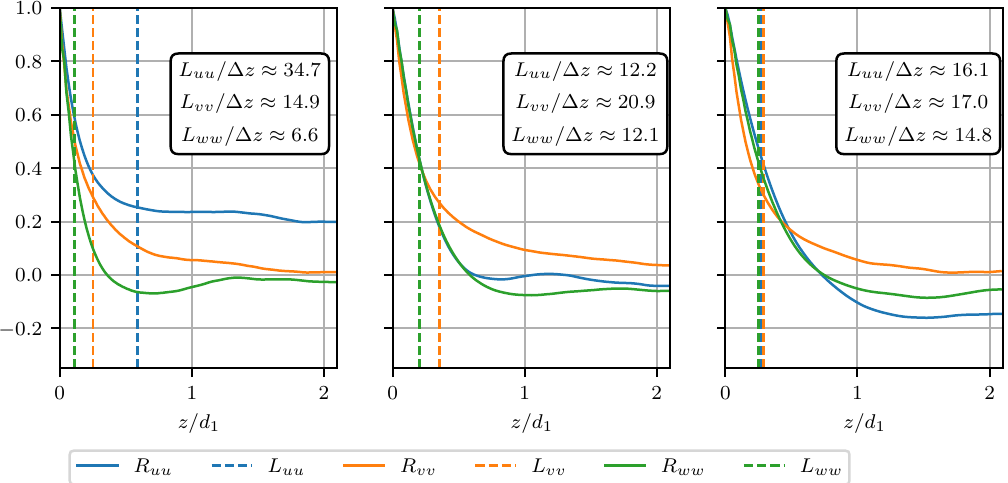
Figure 9. Spanwise two-point auto-correlations of velocity components computed at 3 selected [ x (cid:48) , y (cid:48) ] locations: [ 1.24,1 ] ( left ); [ 3.24,1.1 ] ( middle ); [ 5.24,1 ] ( right ). Vertical dashed lines show the integral length